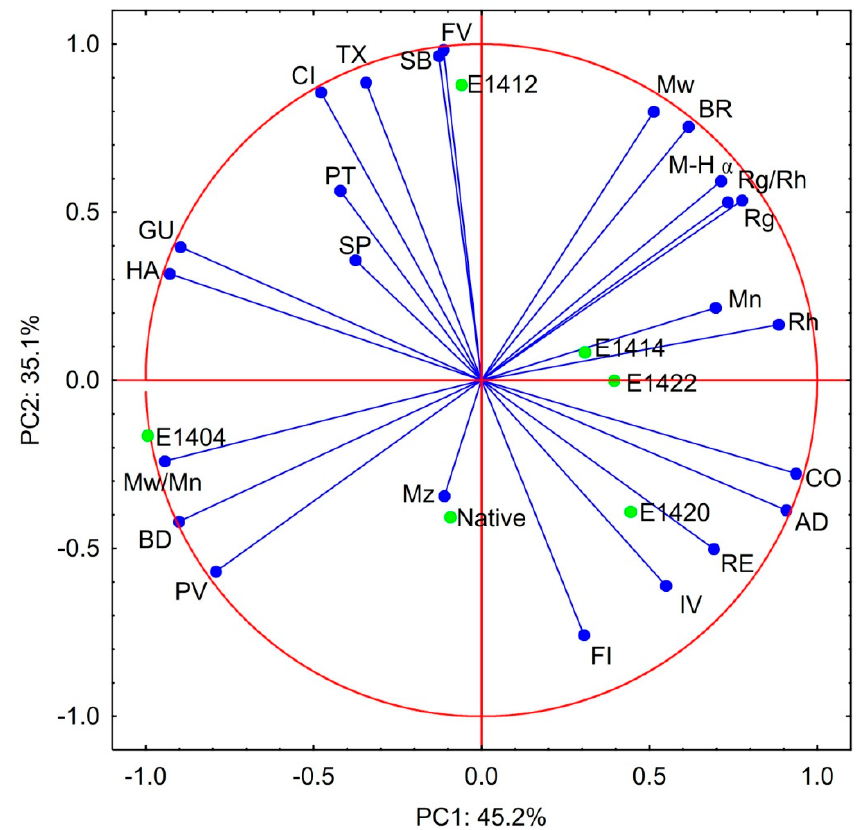
Figure 3. PCA of chemically modified potato starches. Explanatory notes: PT—pasting temperature, PV—peak viscosity, BD—breakdown, SB—setback, HA—hardness, AD—adhesiveness, CO—cohesiveness, RE—resilience, SP—springiness, GU—gumminess, CI—consistency index, FI—flow be-